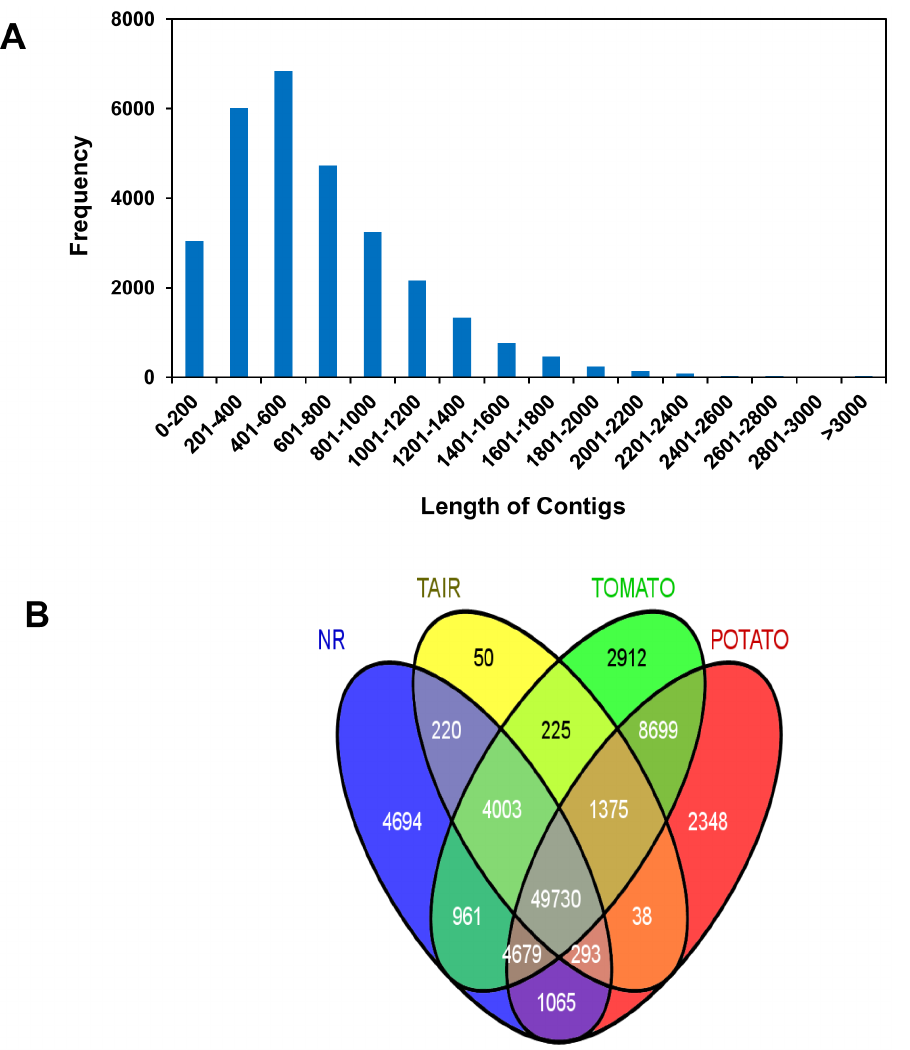
Figure 4. Size distribution of assembled contigs (A) and annotation (B). Raw reads from 101L and 101R were tagged and assembled together. Contigs and singletons generated from combined assembly were annotated using TAIR10, NR, tomato and potato